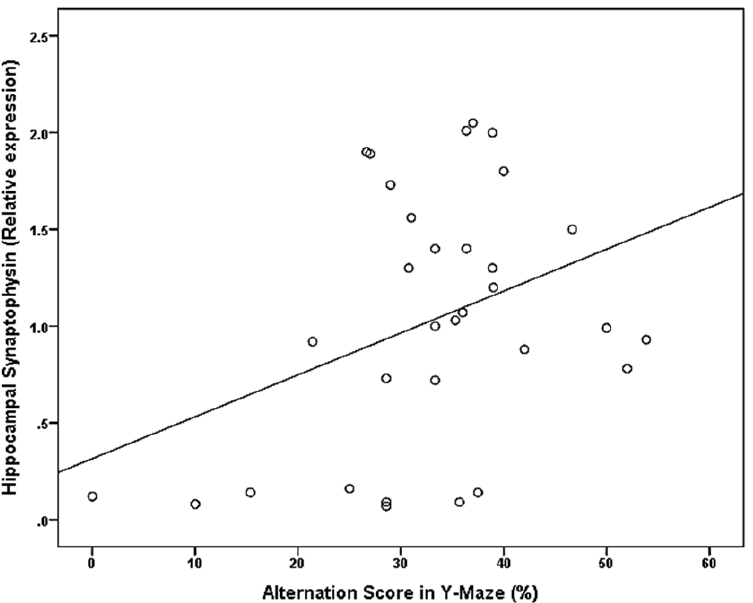
Figure 3. Significant positive correlation between alternation score and hippocampal synaptophy- sin expression.